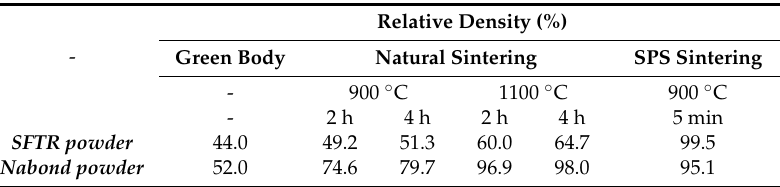
Table 2. Relative densities of ZnO samples from synthesized nanopowder using the SFTR process, and commercial Nabond, by natural sintering and SPS.